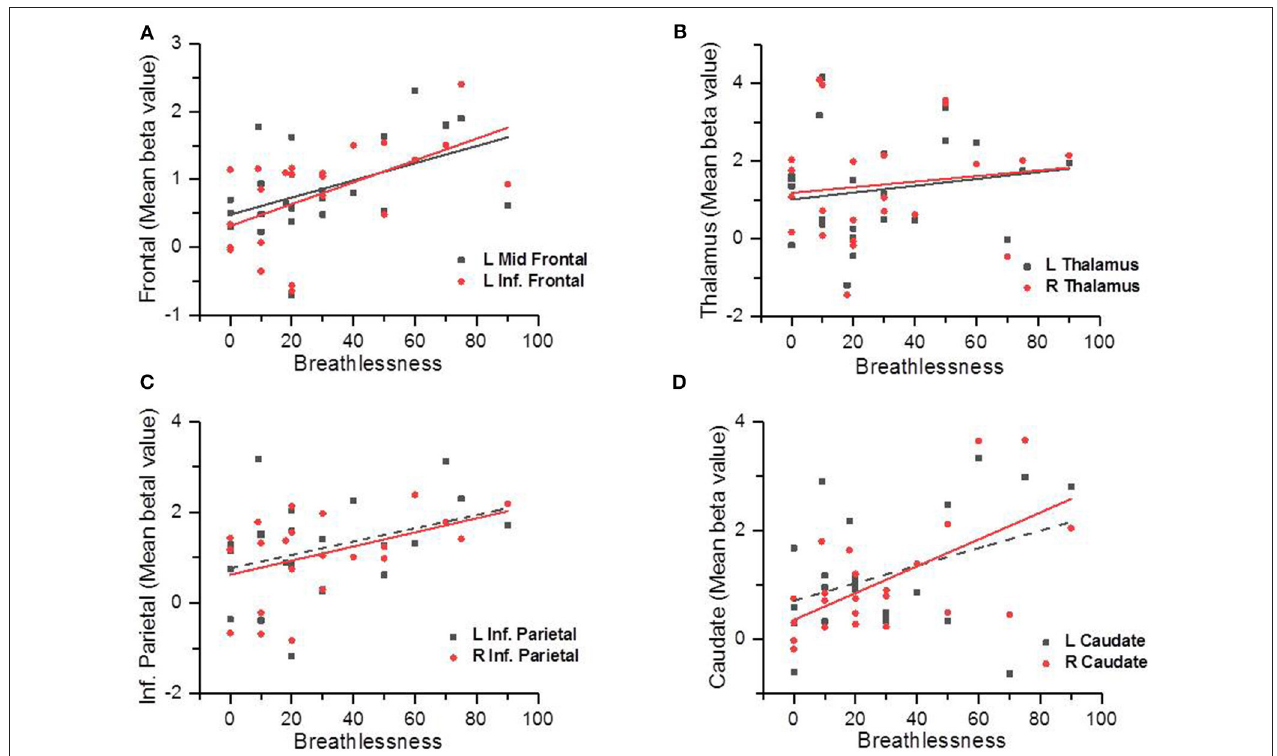
FIGURE 2 | Scatter plots showing the correlations between the participants’ subjective ratings on breathlessness and the brain area activation levels (measured by the beta values); the solid line indicated there was a significant correlation ( p < 0.05) and the dotted line indicated there was no statistically significant correlation ( p > 0.05). Correlations between self-reported breathlessness level and left middle frontal cortex and left inferior frontal cortex (A) , bilateral thalamus (B) , bilateral inferior parietal cortices (C) , and bilateral caudate (D)